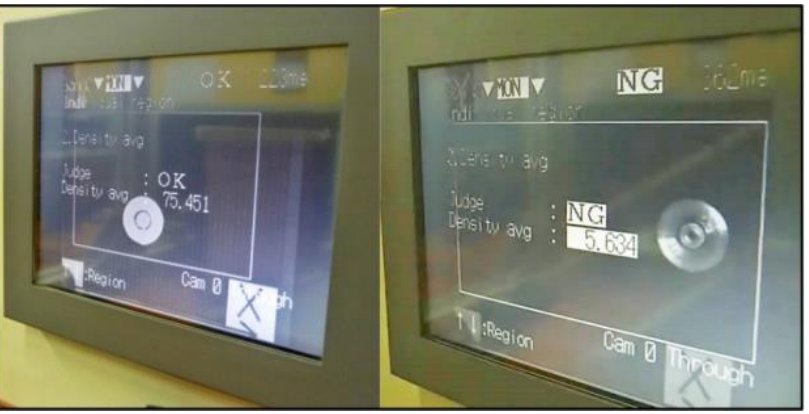
Figure 7. Detection of sensed object presence.